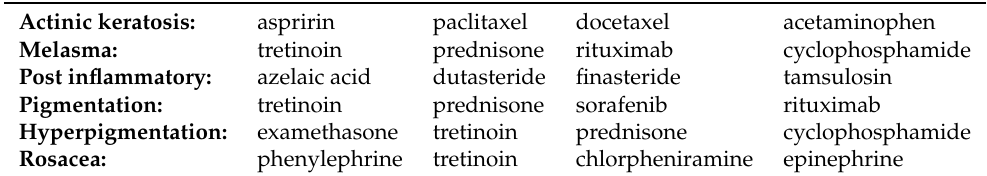
Table 2. Top drugs for different